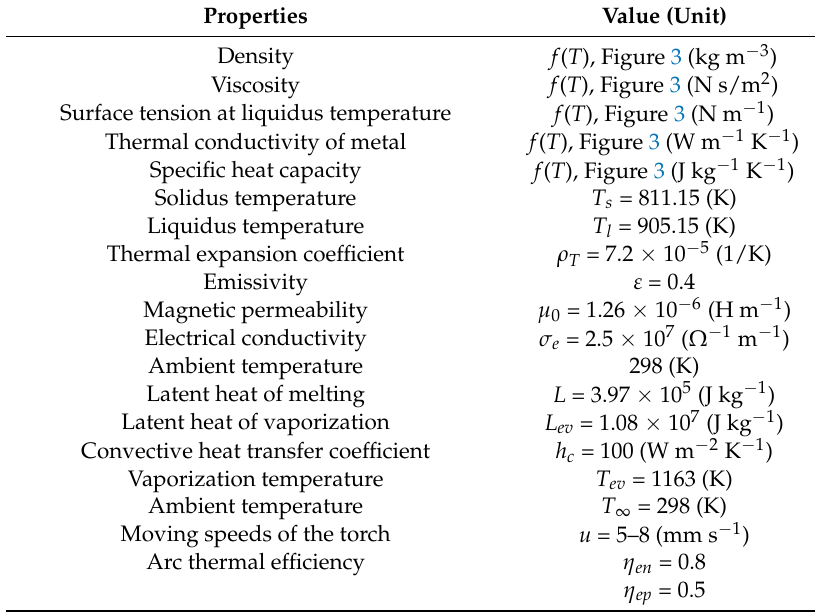
Table 3. Thermo-physical properties of 2024 aluminum alloy and other process variables.